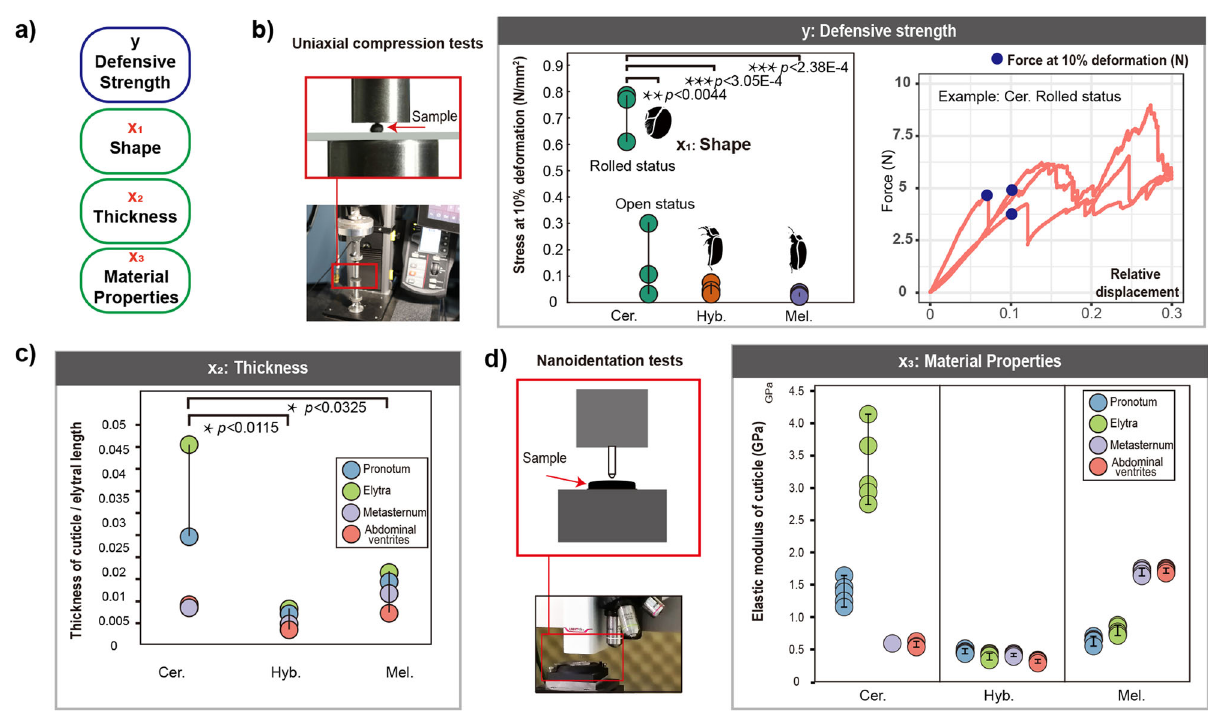
Fig. 3 Functional morphological analysis of conglobation via quantitative measurements of mechanical properties of the body in representatives of Ceratocanthinae, Hybosorinae and Melolonthinae. a Central hypothesis and reasoning regarding the effects of shape, thickness and material properties on the defensive strength of beetles. Each X is an independent variable (cause), while y indicates the dependent variable (result). b Strength of the whole body determined by uniaxial compression tests (forces at 10% height deformation or at breaking points). c Ratio of thickness of cuticle to elytral length: four cuticles of the body wall (four coloured circles) measured by micro-CT scanning. d Material properties (elastic modulus) of four cuticles determined by nanoindentation tests. ∗ p < 0.05, ∗∗ p < 0.01, and ∗∗∗ p <